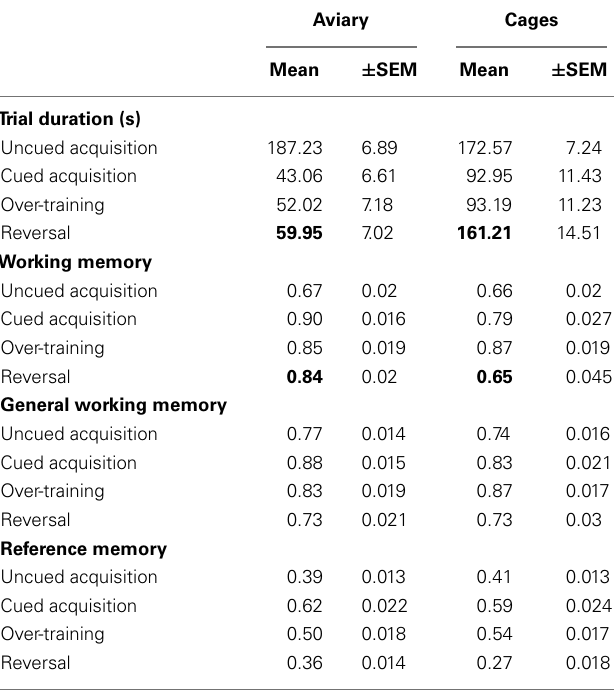
Table 1 | Mean and standard error of the mean ( ± SEM) values for trial duration, working memory, general working memory, and reference memory for aviary- and cage-reared birds in the four training phases of the holeboard task